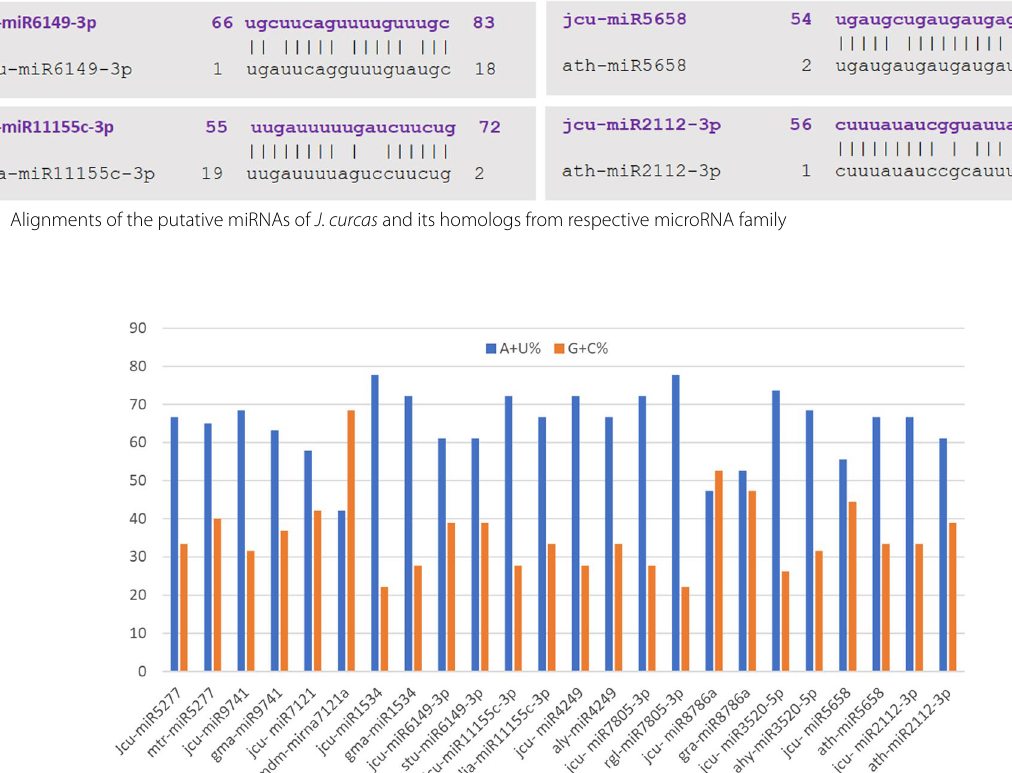
U% and G C%) of putative miRNA from J. curcas and the most related miRNA + +